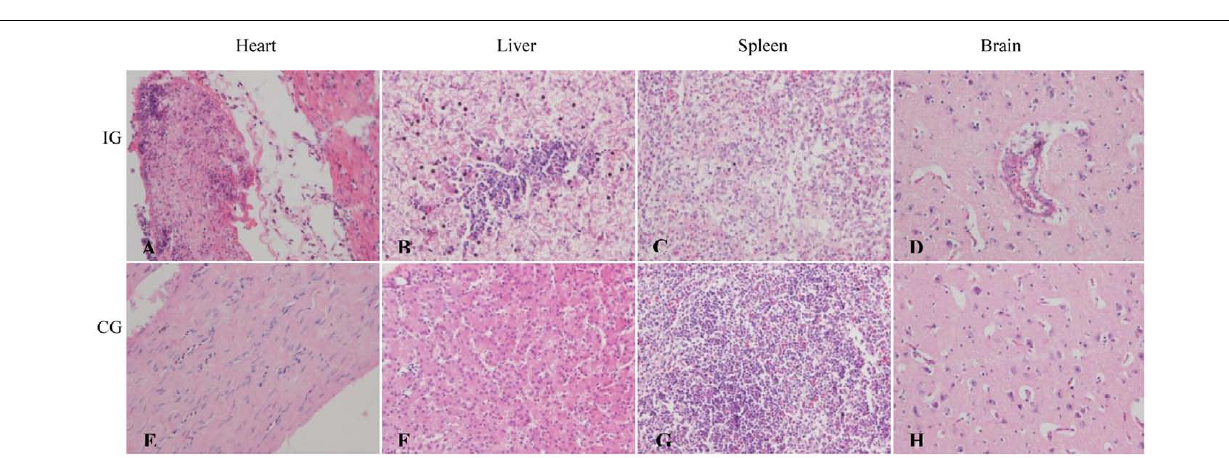
FIGURE 4 | Pathological changes of the APEC-infected ducks. (A) Heart: a large amount of fibrinous exudate, necrosis heterophilic granulocyte and histiocytic cells in the caseous exudate. (B) Liver: diffuse vacuolar degeneration and a lot of necrosis of hepatocyte with lymphocytic infiltration. (C) Spleen: tissue loose, lymphocytic necrosis and heterophilic granulocyte infiltration. (D) Brain: perivascular inflammatory infiltrates. (A–D) Represent the heart, liver, spleen, and brain of ducks from the APEC-infected group, respectively; (E–H) represent the heart, liver, spleen, and brain of ducks from the control group, respectively. Magnification 400 × . IG, infection group; CG, control